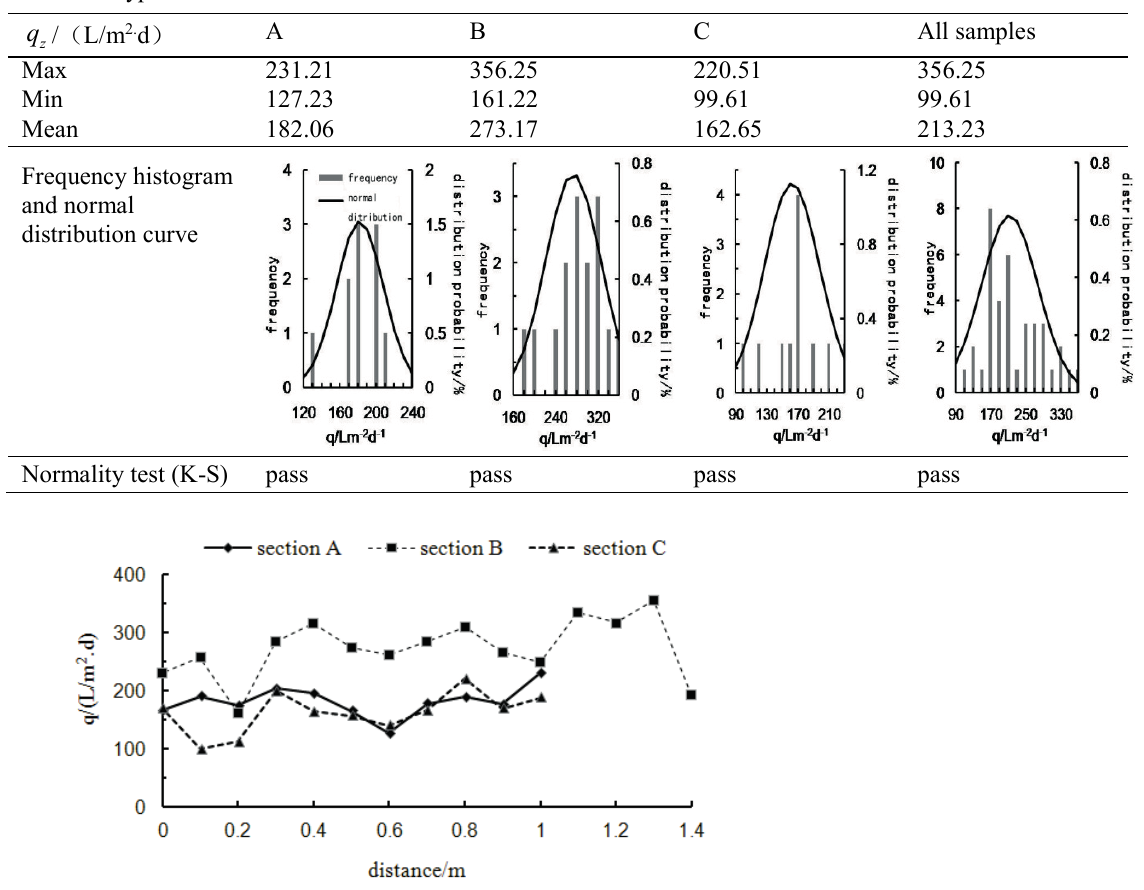
Table 1 Hyporheic flux distribution statistics in the three sections.